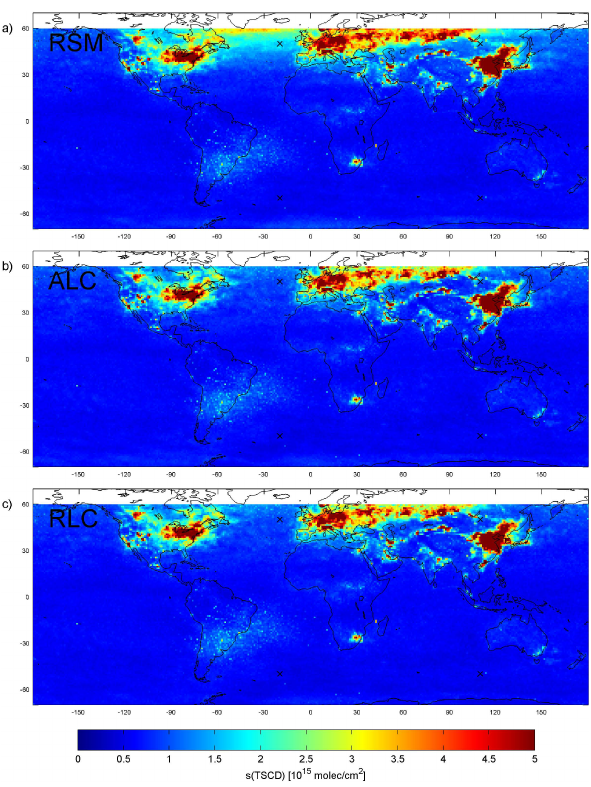
Fig. 9. Standard deviations of tropospheric SCDs for January 2003– 2008. (a) s(T RSM ) , (b) s(T ALC ) , (c) s(T RLC ) .